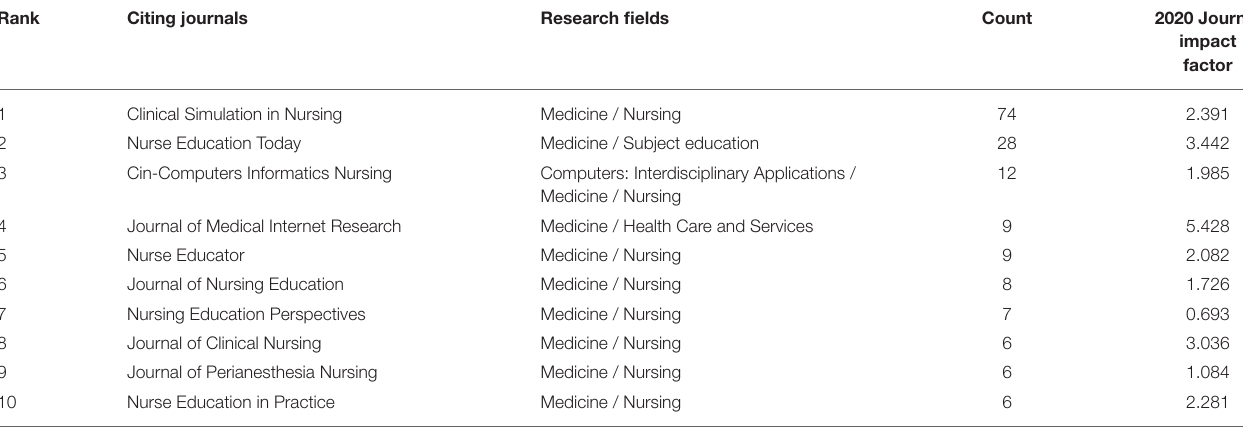
TABLE 3 | The top 10 citing journals of publications on the application of VR in nursing from 2012 to 2021. Rank